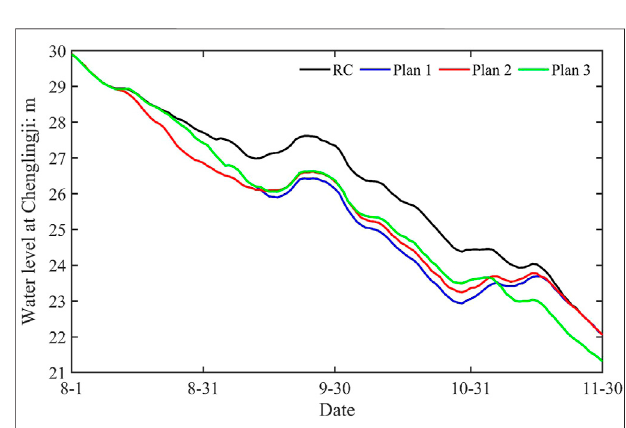
FIGURE 13 | Water level process at the Chenglingji station with different impoundment